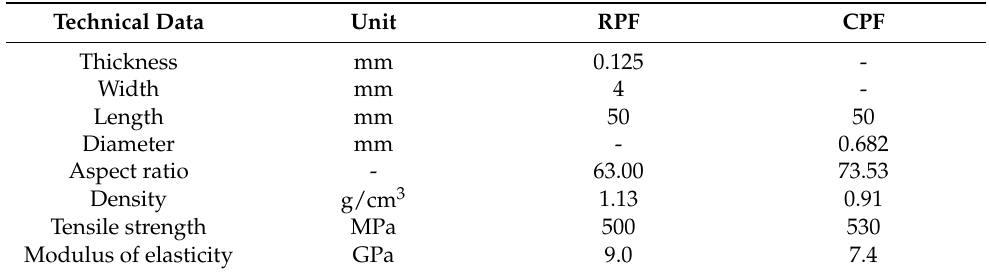
Table 1. Technical data of recycled plastic fibres (RPFs) and commercial polypropylene fibre (CPF). Technical